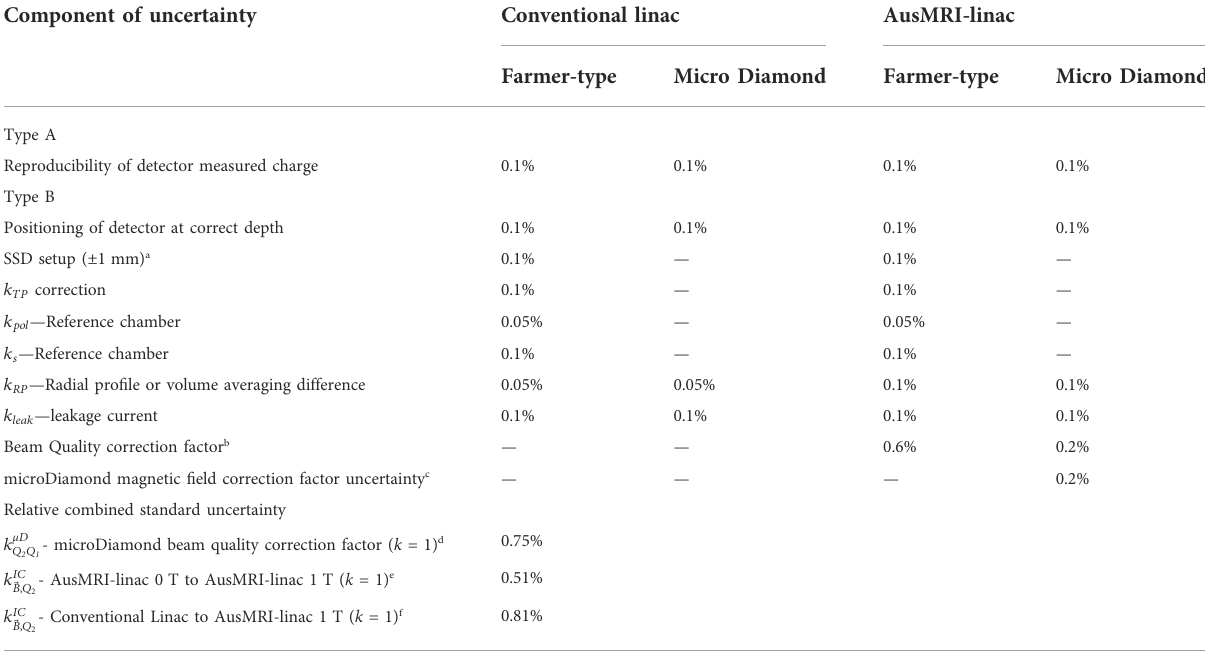
TABLE 1 Uncertainty analysis for the microDiamond beam quality correction factor ( k µD Q determined via measurements on the AusMRI-linac 0 T to AusMRI-linac 1 T and conventional linac to AusMRI-linac at 1 T. The microDiamond beam quality correction factor uncertainty combined all uncertainties via quadratic sum except microDiamond beam quality and magnetic fi eld correction factor uncertainties in calculation. The AusMRI-linac 0 T to AusMRI-linac 1 T combined all uncertainties via quadratic sum except beam quality uncertainty for both detectors and microDiamond magnetic fi eld correction factor. The k IC (cid:2) B , Q AusMRI-linac at 1 T combined all uncertainties via quadratic